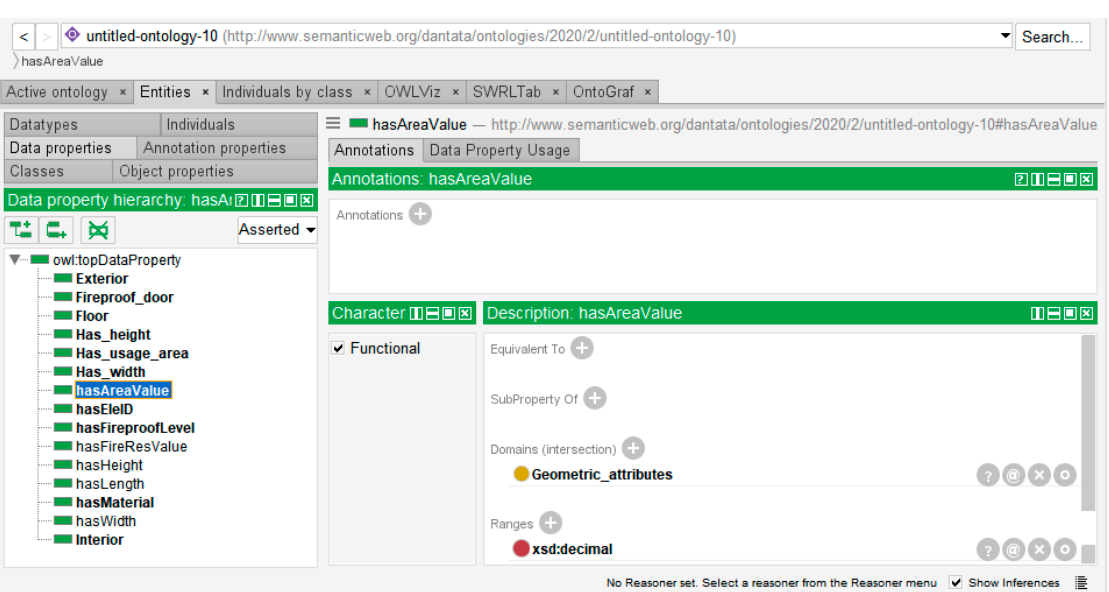
Figure 14. Data properties of the DFS ontology in Protégé.